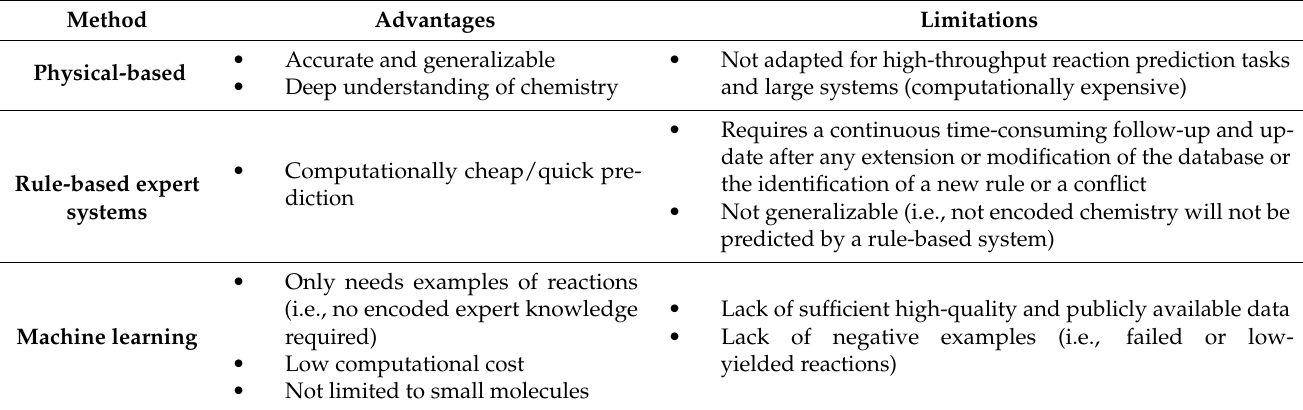
Table 5. Comparison of the three major approaches in reaction prediction and